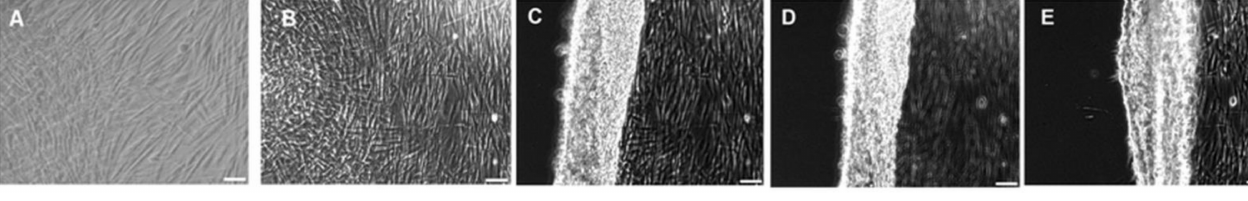
Figure 9. Images of fibroblasts on the ( A ) TCPS control layer, ( B ) P(TEGMA-EE) layer after 24 h of incubation at 37 ◦ C and after ( C ) 5 min, ( D ) 10 min and ( E ) 20 min of incubation at 17.5 ◦ C. The scale bars are 100 µ